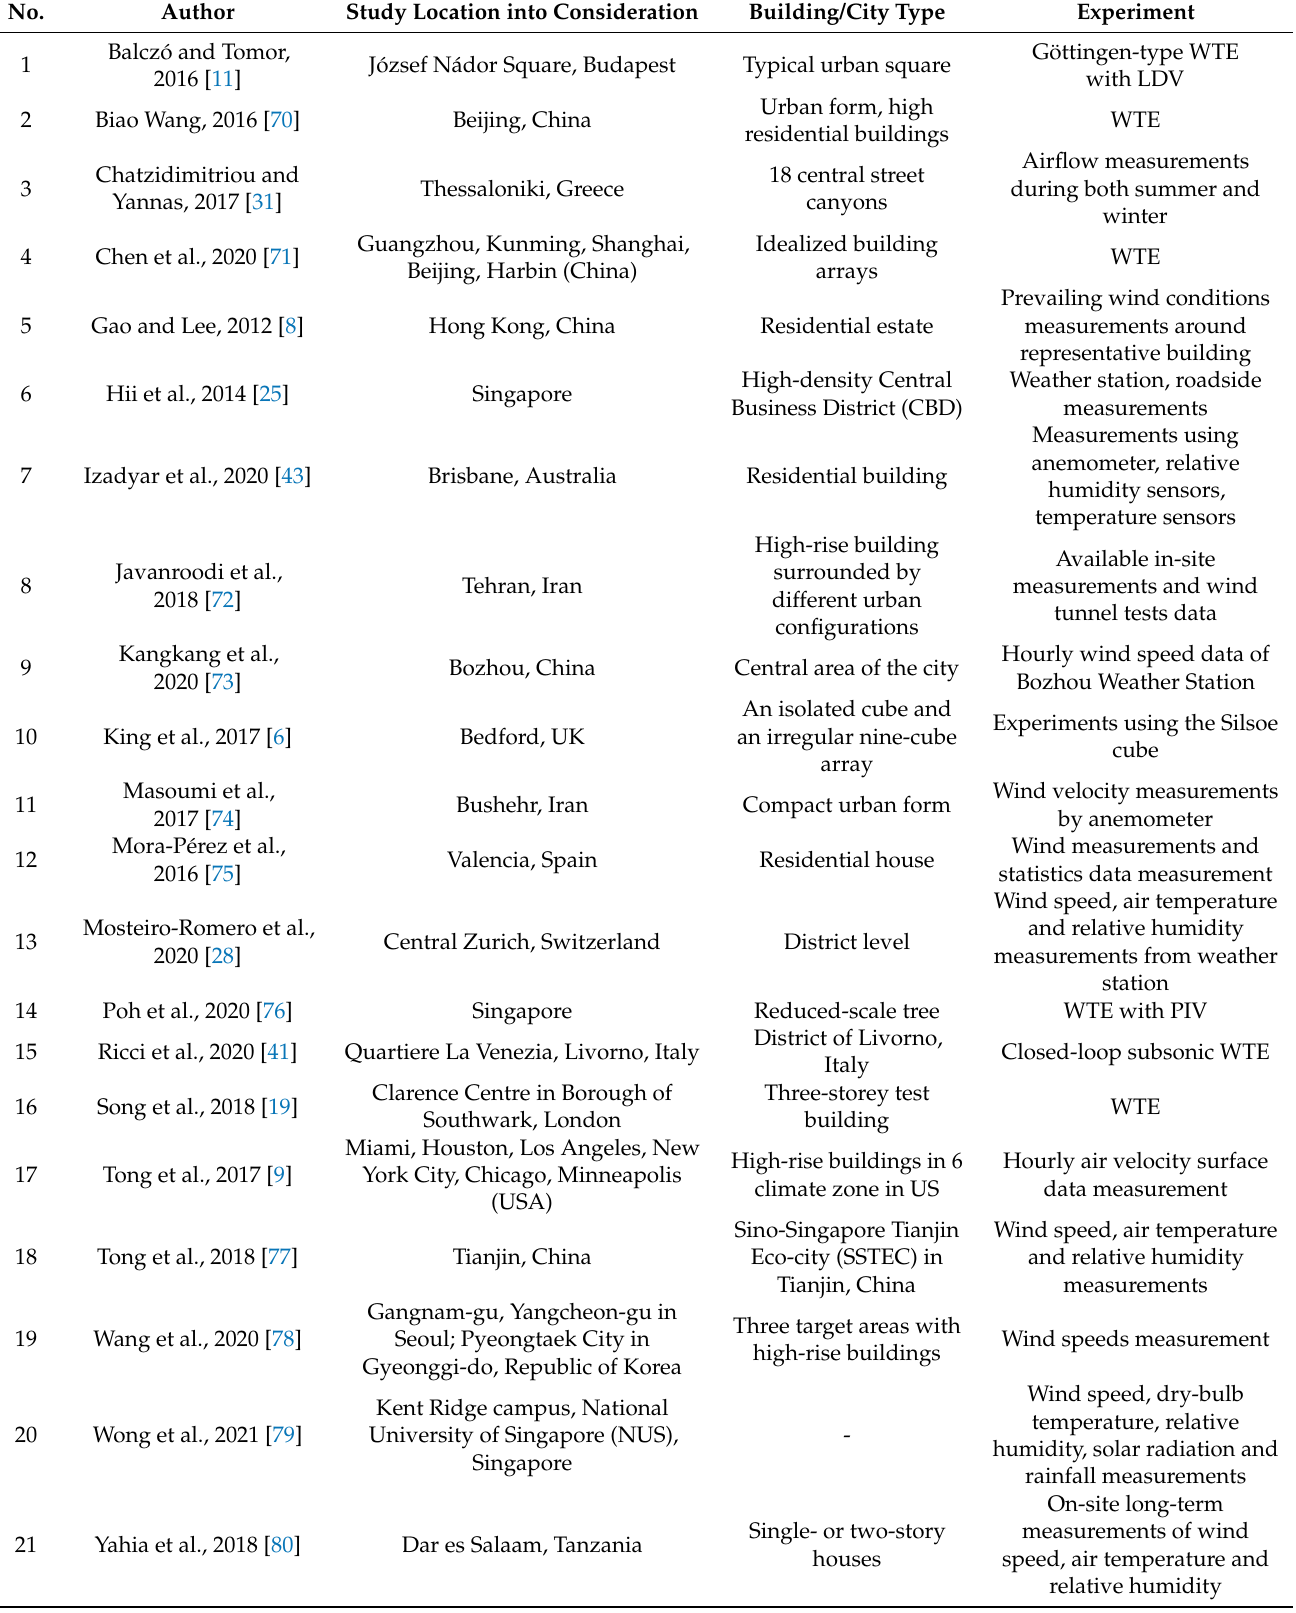
Table 5. Overview of studies of real urban areas with validation comparison with experimental or numerical data: name and type of studied location and type of